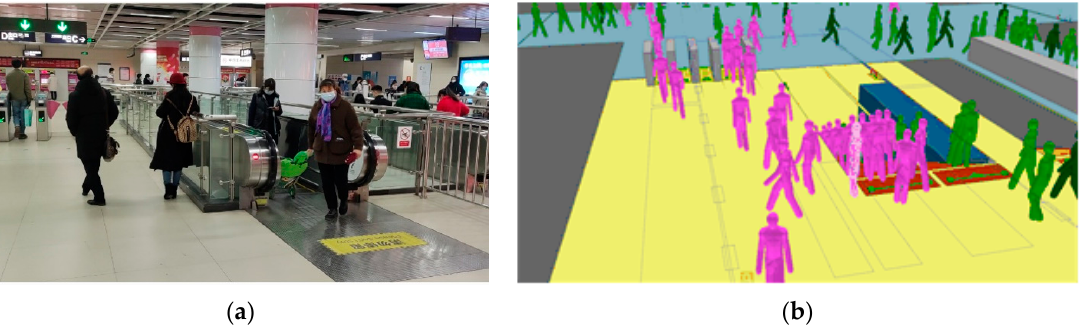
Figure 10. Observed and simulated pedestrian distribution at the stairway of the concourse floor: ( a ) Observed result; ( b ) Simulation result.